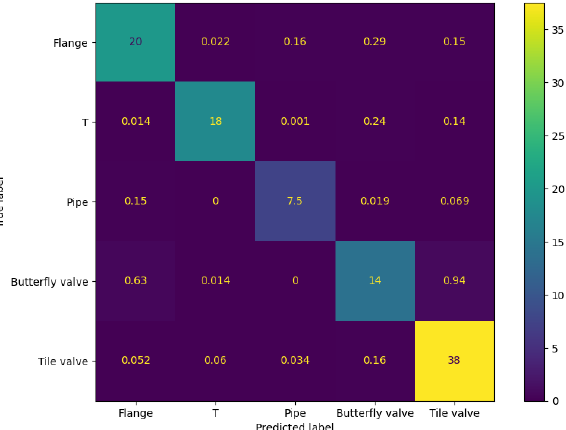
Figure 8: Normalized confusion matrix on images, each box cor- responds to a percentage of the total data